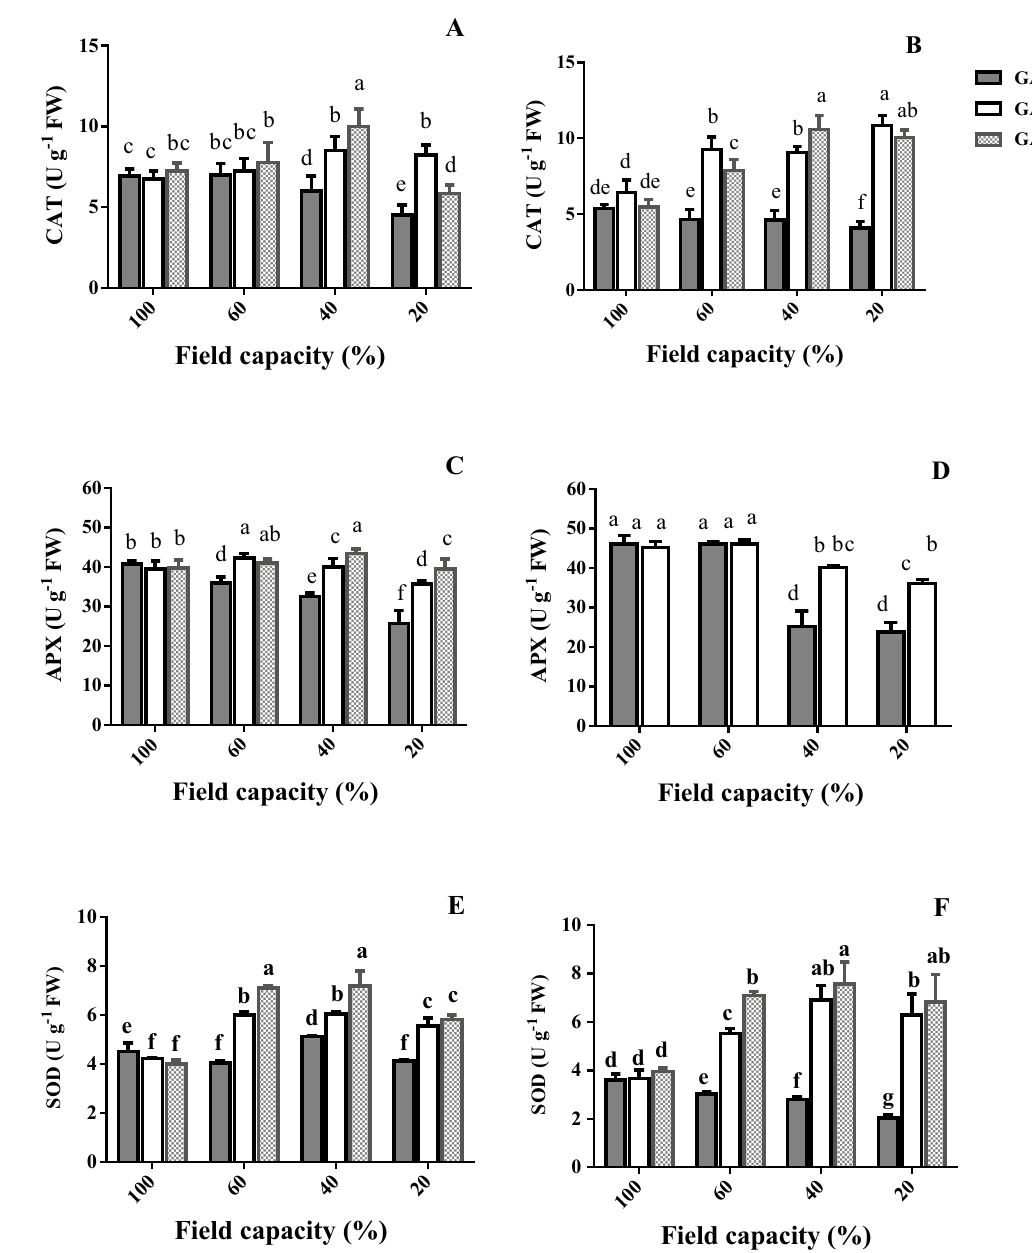
Figure 8. Leaf catalase (CAT; A , B ), ascorbate peroxidase (APX; C , D ) and superoxide dismutase (SOD; E , F ) activity of cv. Arman (tolerant; left panels) and cv. Azad (sensitive; right panels) chickpea plants receiving exogenous application of γ-aminobutyric acid (GABA) at different concentrations (0, 25 and 50 μM) under different watering levels (100, 60, 40 and 20% field capacity) during cultivation. Within each insert, different letters indicate significant differences. Error bars indicate SEM (n = 3). FW fresh weight, U